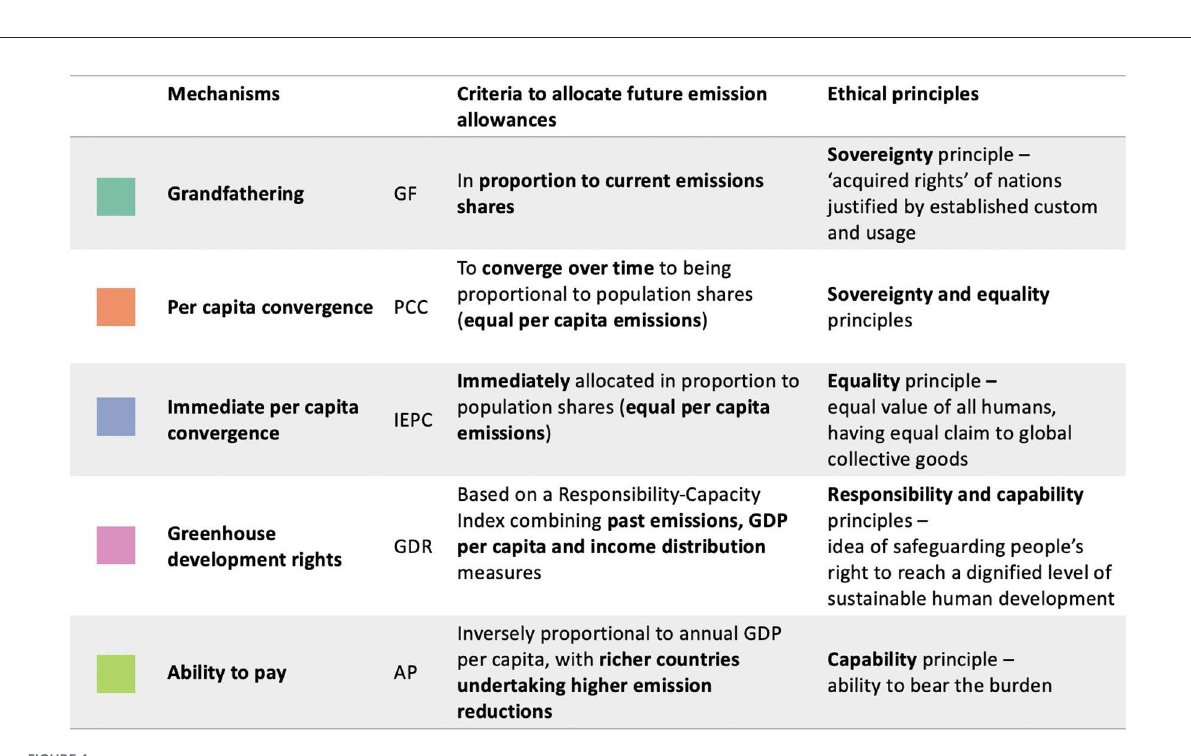
In the next step, stakeholders were shown three panels for four indicators that we asked about in our brief surveys (see also Section 2.3.5.2): (1) the share of non-biomass renewables in 2030; (2) the share of Carbon Capture and Storage (CCS) technologies in total electricity generation in 2030; (3) the level